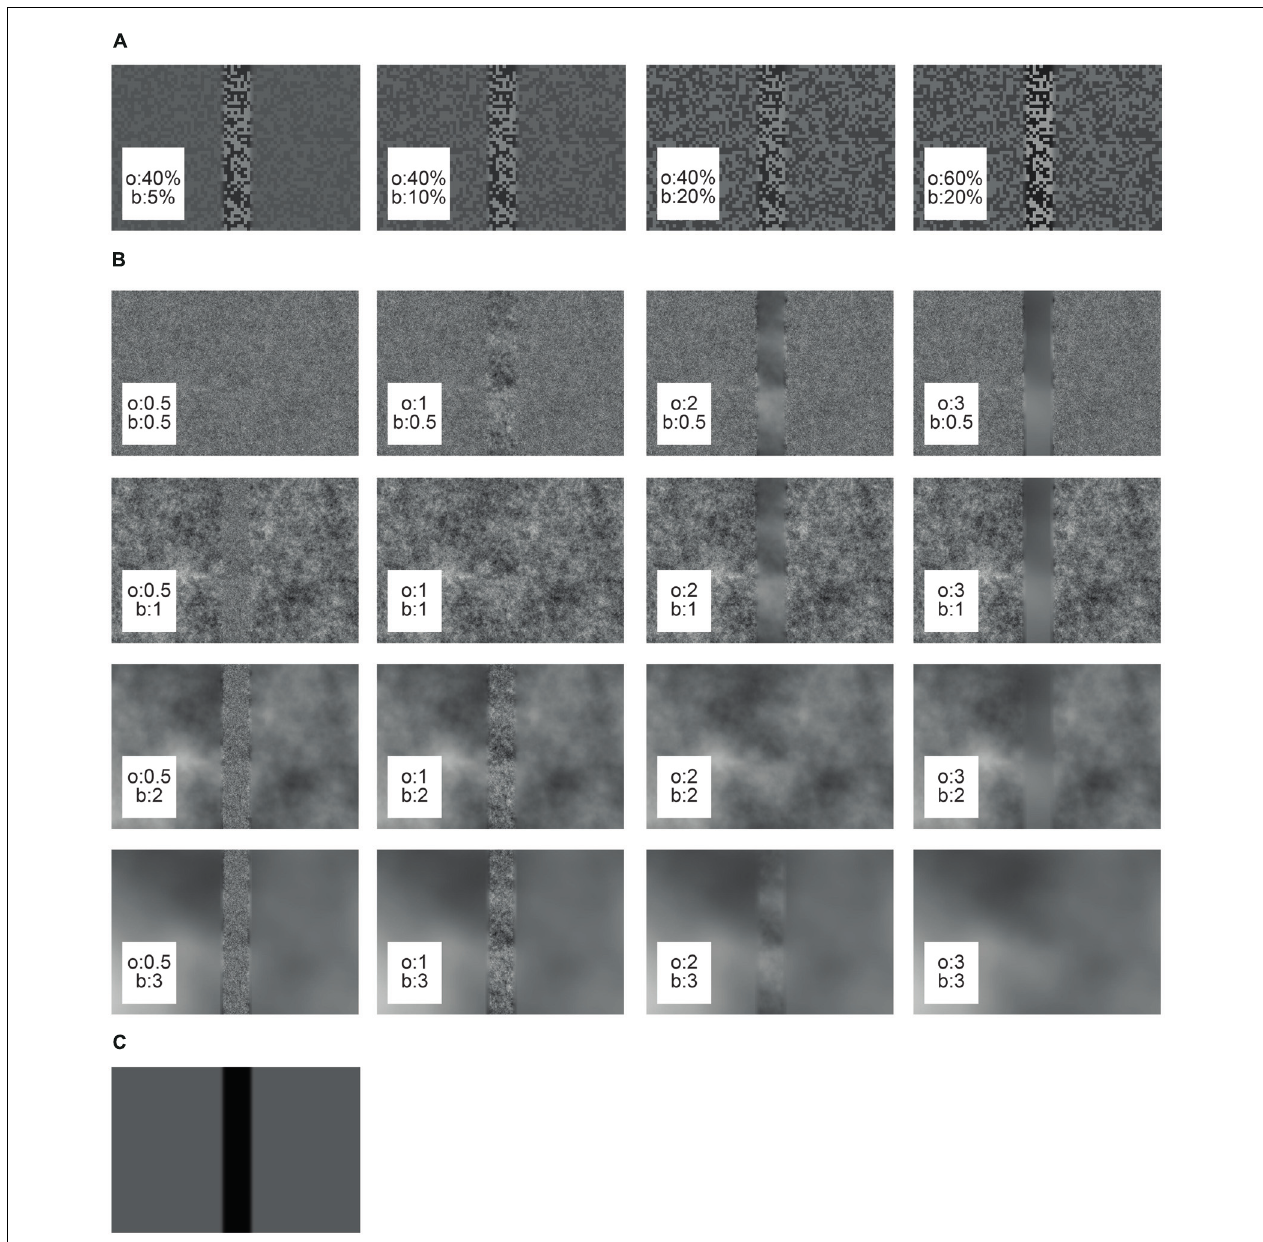
FIGURE 2 | Cut-outs of different arena wall textures used in this study. The object texture (o) is embedded in the background texture (b). (A) Contrast textures, (B) spatial frequency textures, (C) reference texture.